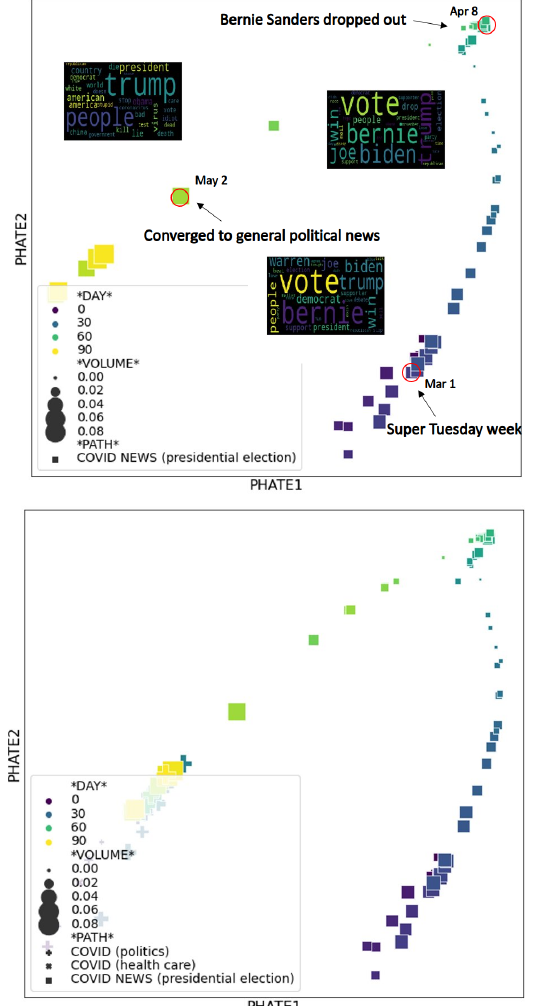
Figure 5. Potential of heat-diffusion for affinity-based transition embedding (PHATE) for subsets of topics in the COVID NEWS cluster (bottom) and the presidential election path (top) within the cluster. Colors and sizes highlight time and tweet volumes, respectively. Here three word clouds containing top 30 words in corresponding topics are shown for the time points highlighted by red circles, showing important real-word events that are annotated. Note the plot at the bottom shows (near lower left) the merge and split of different paths (labeled by filled squares, crosses, and pluses) within the same